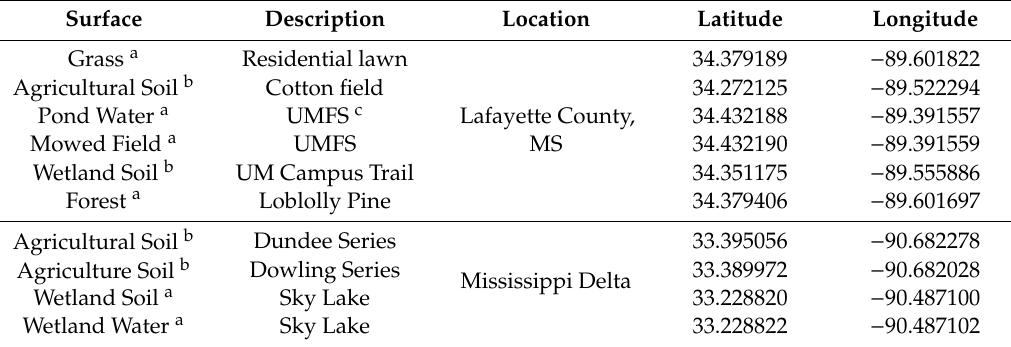
Table 1. General description and location of sampling